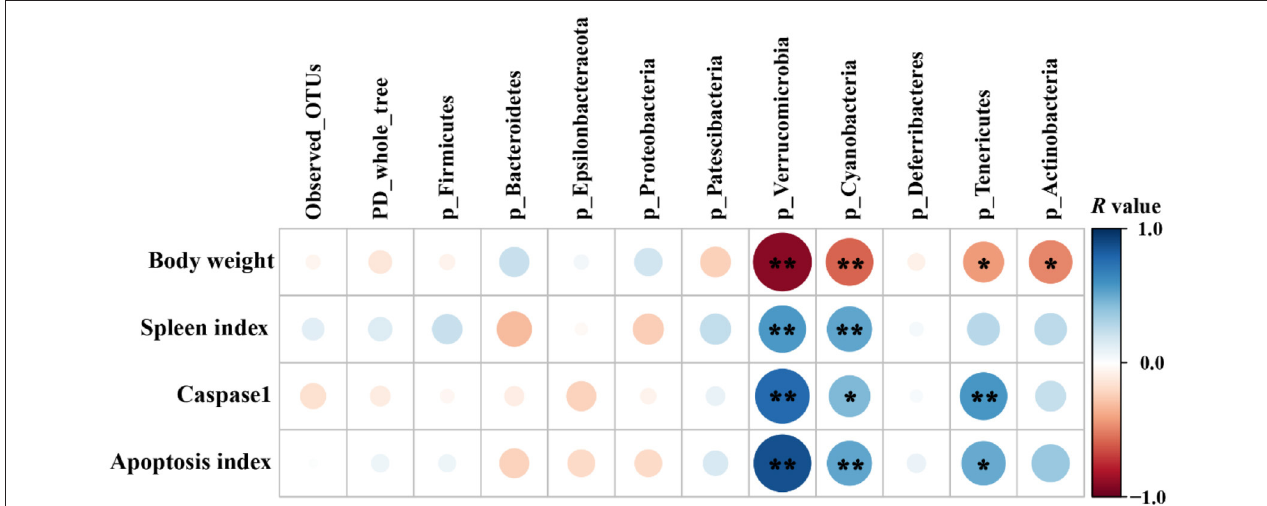
FIGURE 10 | Pearson’s correlation analysis between phenotypic variables and the relative abundance of microbial communities (phylum level, n = 4/group). The color and dot size represent the correlation coefficient within rows. * P < 0.05; ** P < 0.01.